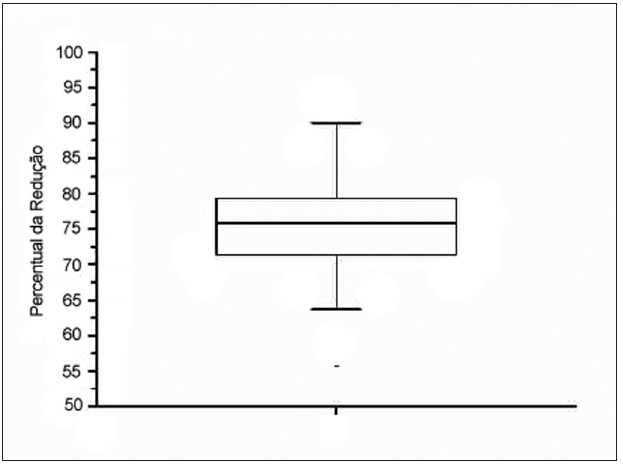
Gráfico 2. Representação gráfica do percentual de redução da área das VAS durante o sono induzido.